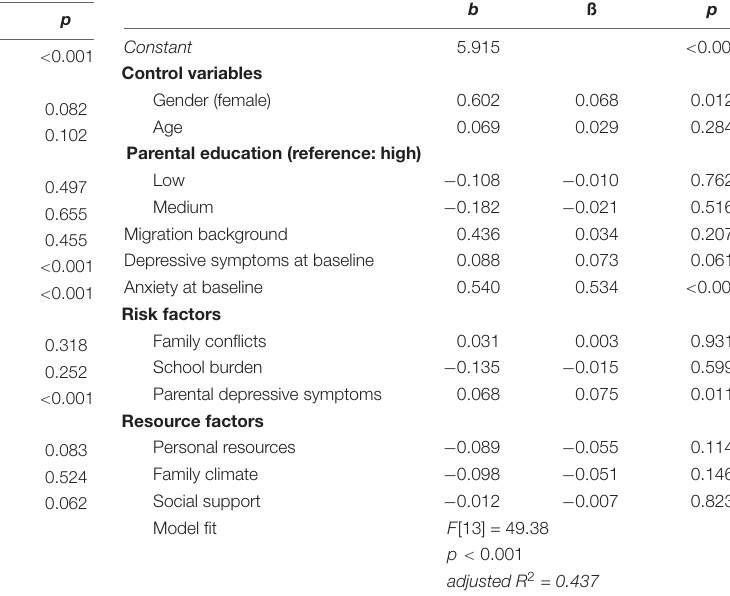
TABLE 3 | Results of the multivariate linear regression analyses; risk and resource factors in children and adolescents predicting depressive symptoms 6 months